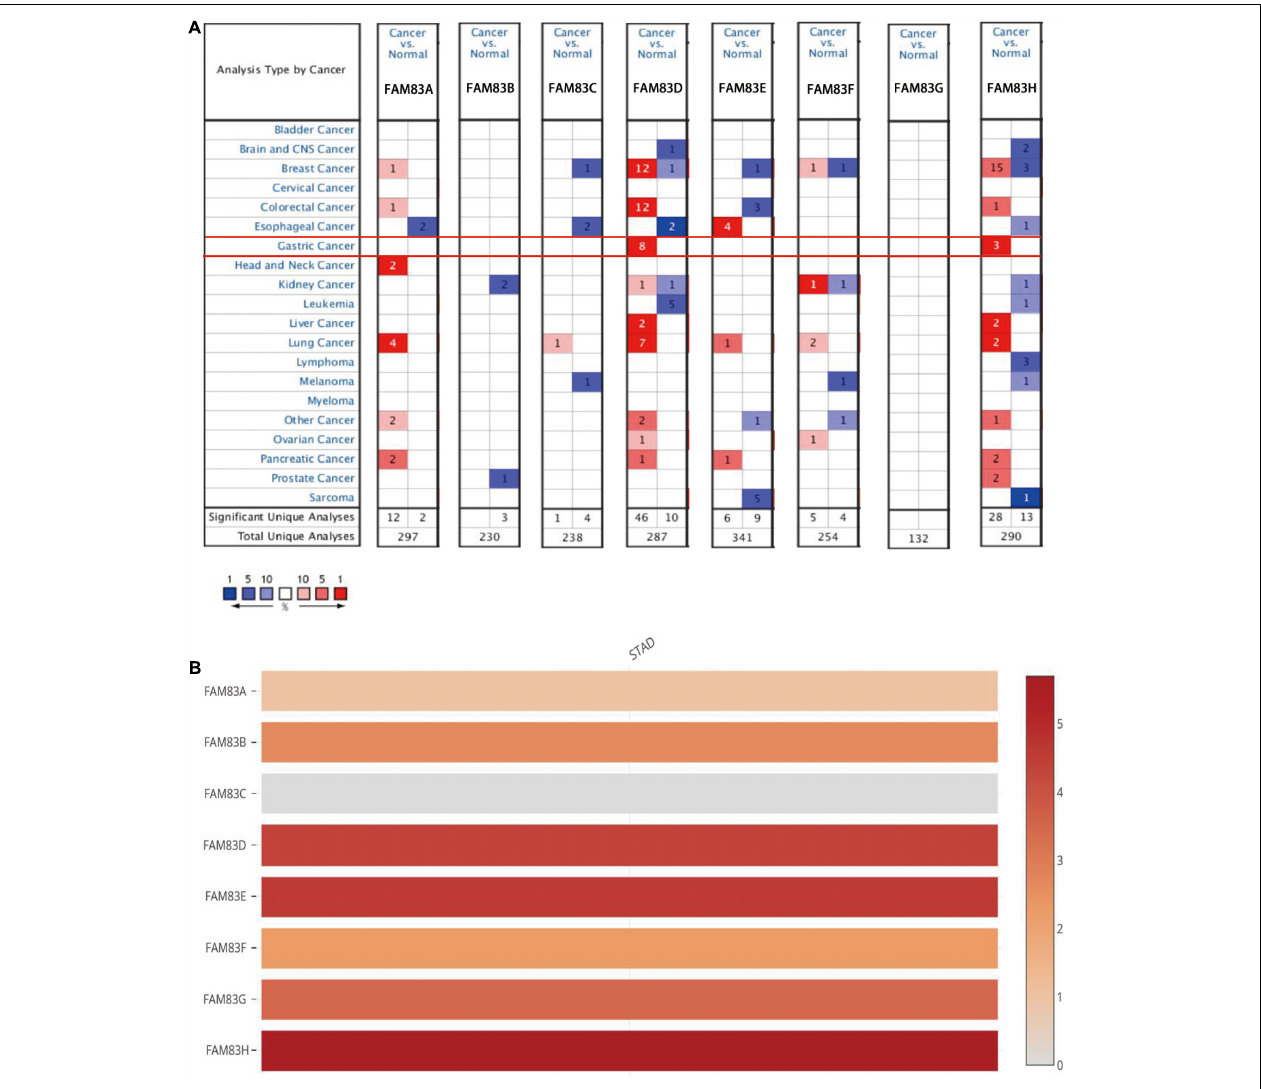
FIGURE 1 | The mRNA expression level of FAM83 family in STAD and other distinct types of cancer (ONCOMINE and GEPIA database). (A) This figure shows the number of datasets with statistically significant mRNA up-regulation (red) or down-regulation (blue) in the FAM83 family. The student’s t -test was used to compare different transcriptions. The cut-off values of p -value and fold change were as follows: p -value: 0.05, fold change: 2, gene rank: 10%, data type: mRNA. (B) Relative level of FAM83 family members in STAD. FAM83H was the highest mRNA expression in